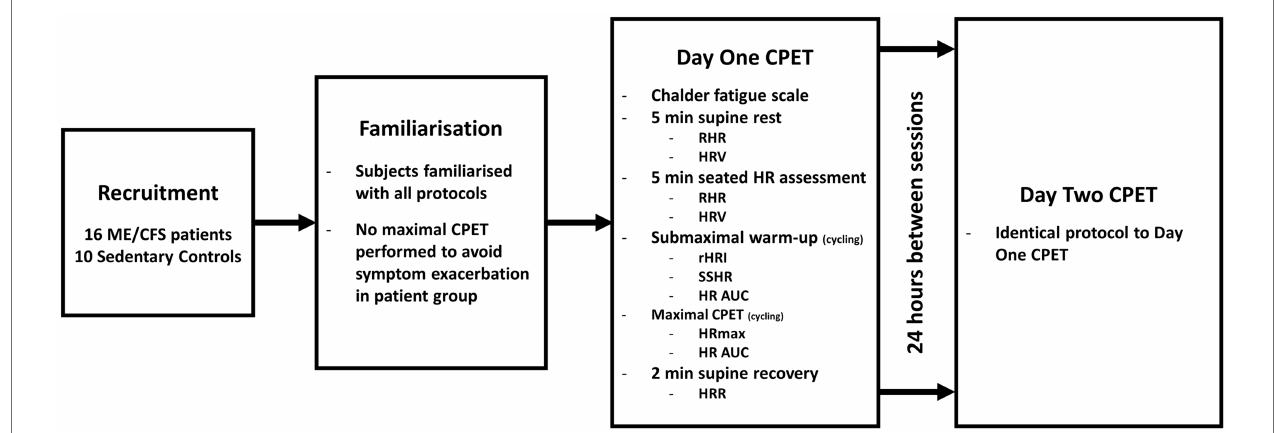
FIGURE 1 | Diagram of study design. ME/CFS , Myalgic Encephalomyelitis/Chronic Fatigue Syndrome; CPET , cardiopulmonary exercise test; min , minutes; RHR , resting heart rate; HRV , heart rate variability; HR , heart rate; rHRI , maximal rate of heart rate increase; SSHR , steady state heart rate; AUC , area under the curve; HRmax , maximal heart rate; and HRR , heart rate